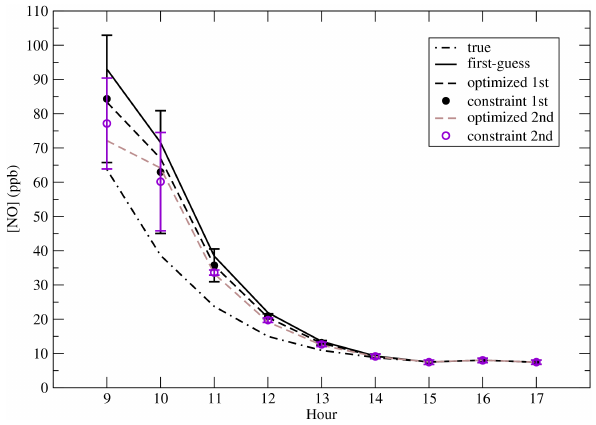
Fig. 8. Times series of NO concentrations for the true inventory, the first-guess +100% inventory and the analysis obtained with (cid:15) m =10% in the southwest part of the city for the first and second optimizations.